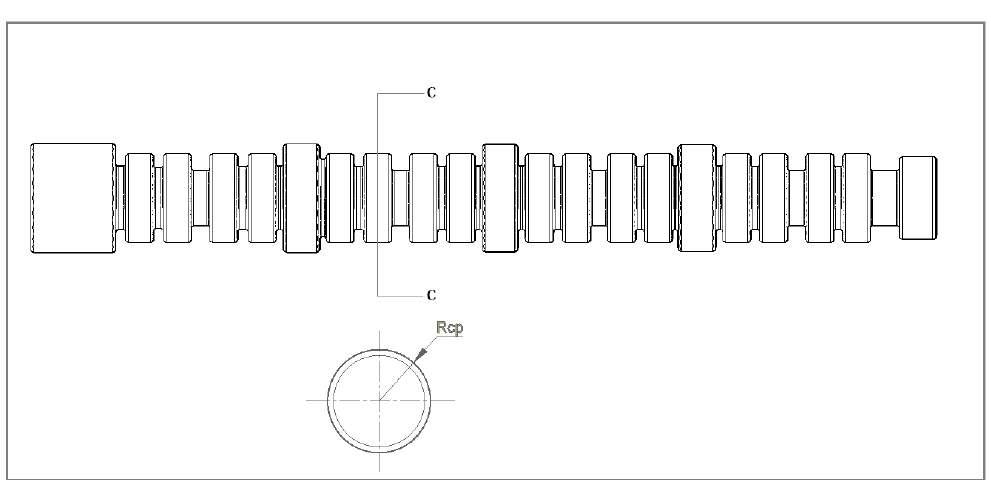
Figure 4. Radius of the base circle of Cams in the Preform.